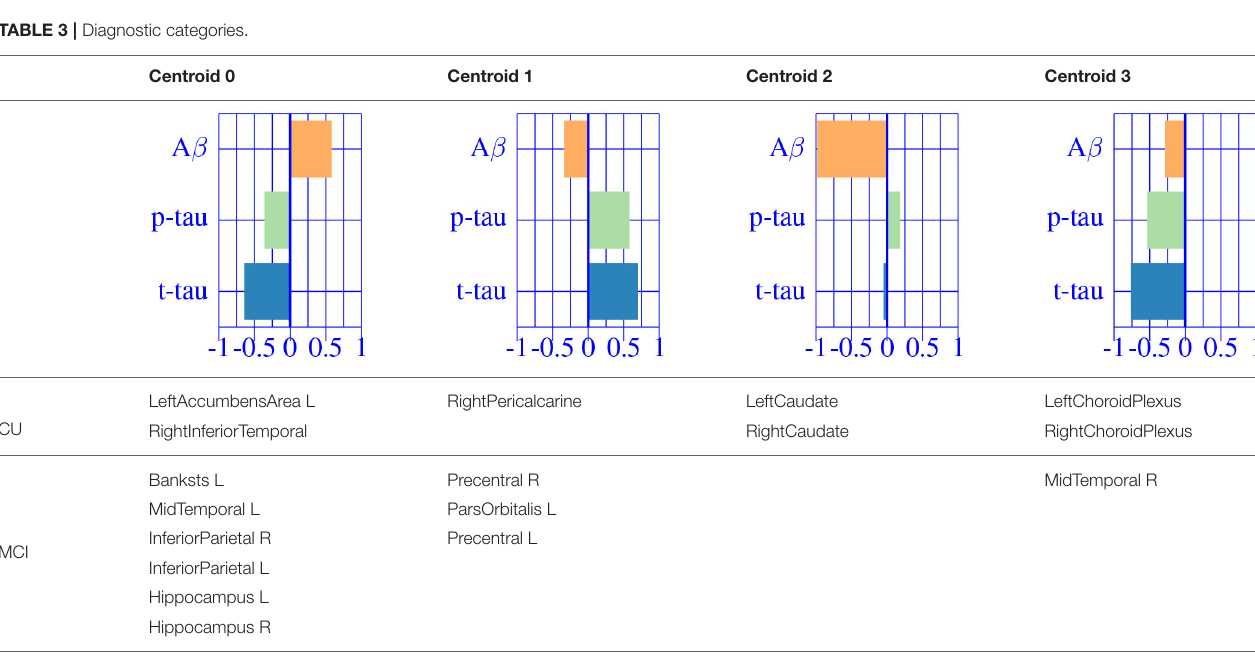
FIGURE 5 | Different views of the effect of AD ( ν AD k ) in subjects in the MCI stage. The color-code represents negative (blue) and positive (red) relative contributions of each CSF biomarker explaining the volumetric variability on brain each ROIs. Each figure represents a different CSF biomarkers: (A) CSF A β , (B) CSF p -tau, (C) CSF t -tau. Only brain ROIs with statistically significant effect size ( p < 0.05, corrected for multiple comparisons) are shown.